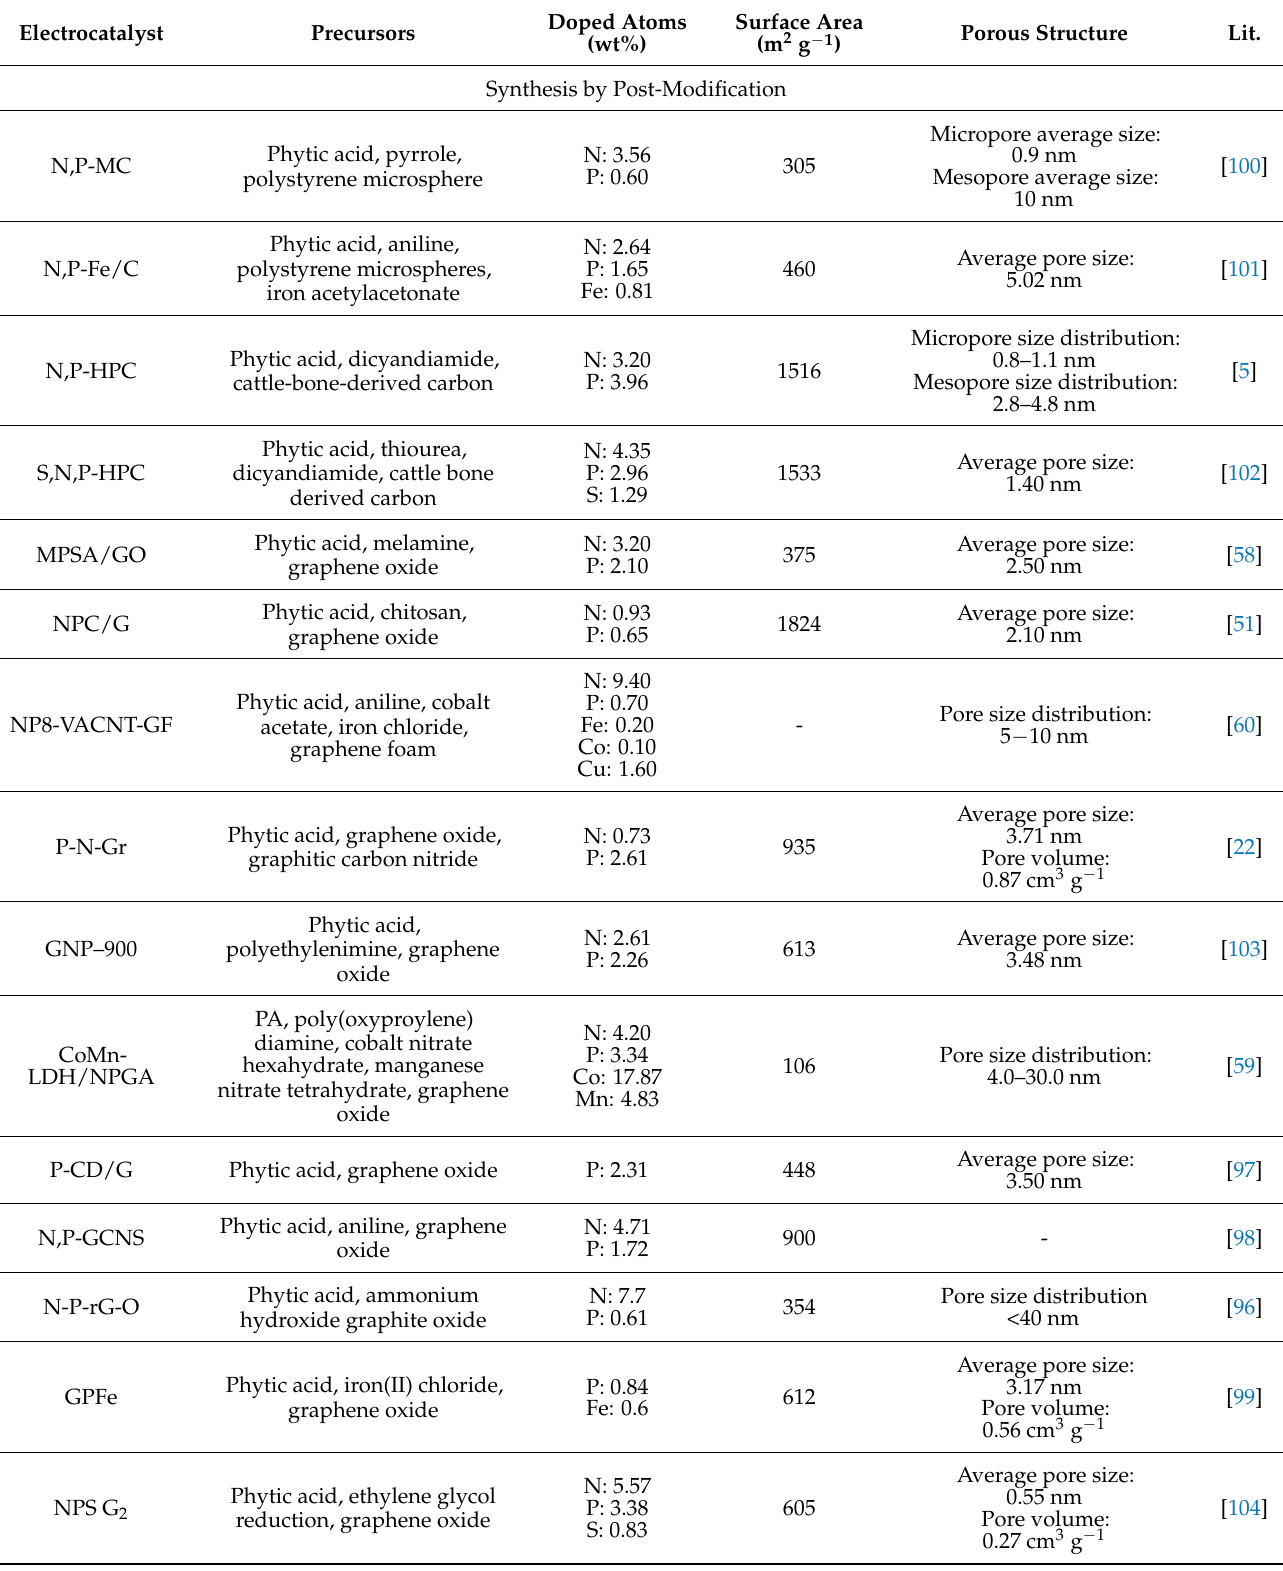
Table 3. Physicochemical properties of PA-derived carbon materials obtained by post-modification.